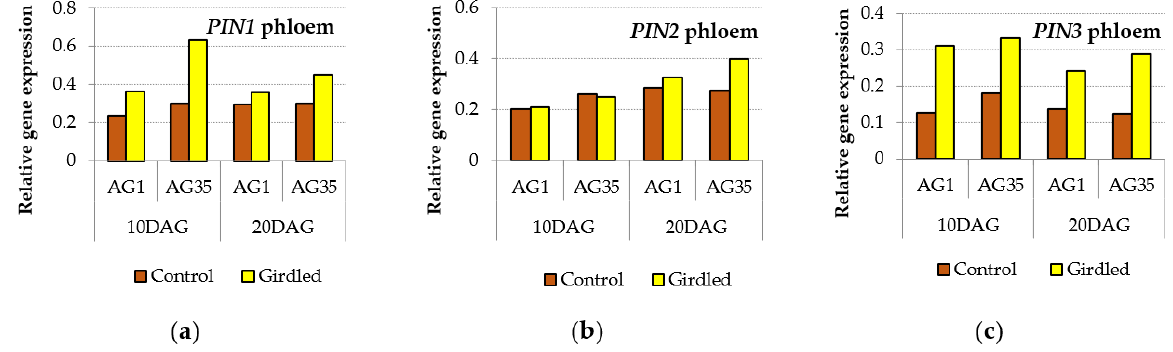
Figure 11. Relative gene expression of PIN1 ( a ), PIN2 ( b ), and PIN3 ( c ) genes in the phloem of control and girdled trees.